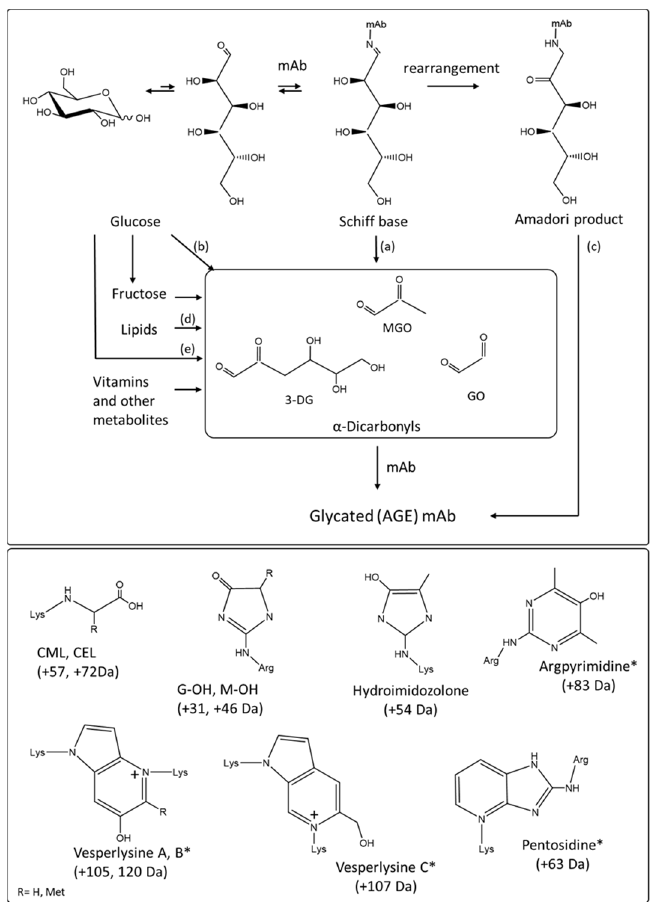
Figure 5. (top panel) AGE products formation through rearrangements, oxidative glycosylation and non-oxidative degradation of the shiff base between a reducing sugar and the reactive side chain of a protein amino acid (lysine, arginine), and through formation of dicarbonyl products through oxidative and non-oxidative degradation of carbohydrates. ( a ) Namiki pathway ( b ) oxidative oxidation, ( c ) oxidative and non-oxidative pathways ( d ) peroxidation ( e ) non oxidative pathway. 3-DG stands for 3-deoxyglucasone, GO stands for glyoxal, MGO stands for methylglyoxal. Adapted from Reference [37]. (lower panel) Chemical structure of representative fluorescent (*) and non-fluorescent AGE products derived from lysine and arginine: Nε-carboxymethyl-lysine (CML), Nε-carboxyethyl-lysine (CEL), Glyoxal hydroxyimidazolone (G-OH), Methyl glyoxal hydroxyimidazolone (M-OH), Hydroimidozolone, argpyrimidine, vesperlysines A, B and C, pentosidine. Changes in mass for each AGE degradation product are shown. Spectrophotometric properties of these are shown in Table 2.